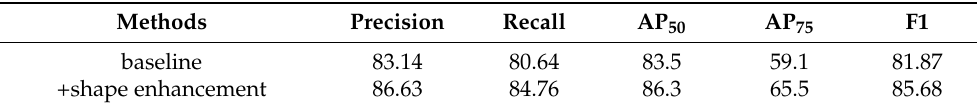
Figure 7. Visualization detection results of different scene for ablation study: ( a ) ground truth; ( b ) the Swin Transformer with FCOS; and ( c ) proposed model. Table 3. Ablation study of the edge-guidance shape-enhancement module. + refers to adding the following module based on the baseline